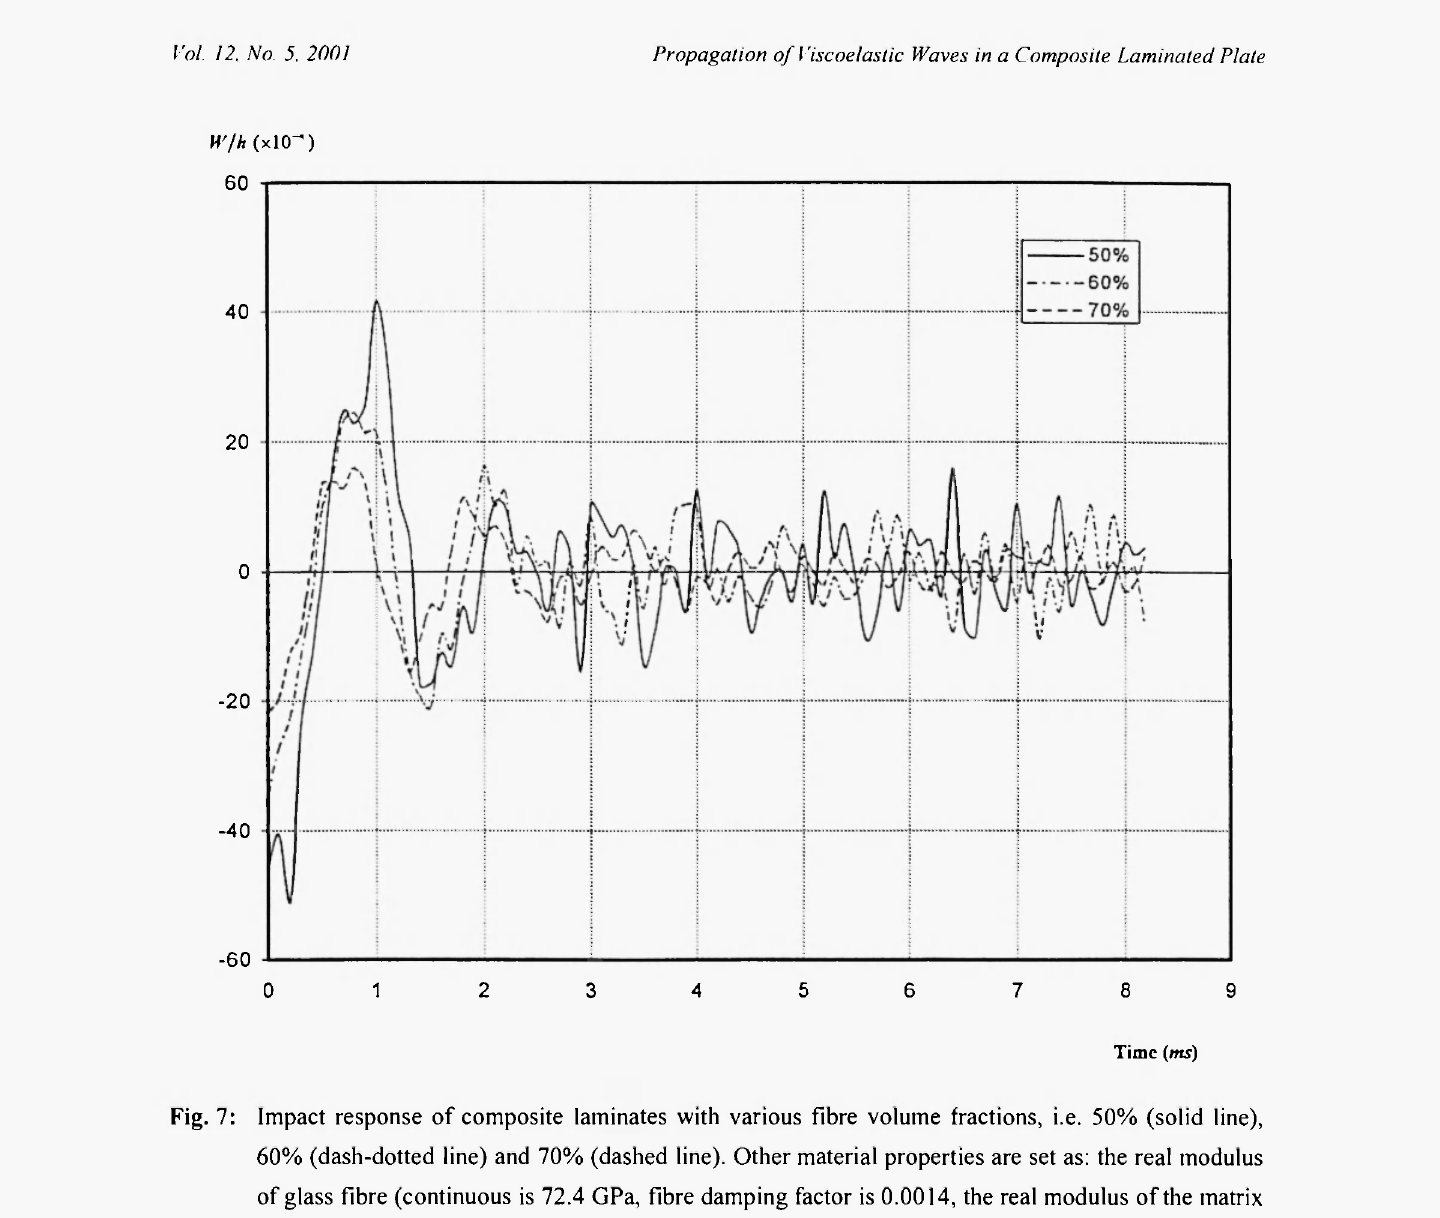
Fig. 7: Impact response of composite laminates with various fibre volume fractions, i.e. 50% (solid line), 60% (dash-dotted line) and 70% (dashed line). Other material properties are set as: the real modulus of glass fibre (continuous is 72.4 GPa, fibre damping factor is 0.0014, the real modulus of the matrix is E mr = 1158 (1 + 1 0 0 / ) ° w i t h / as frequency, and damping factor of the matrix is